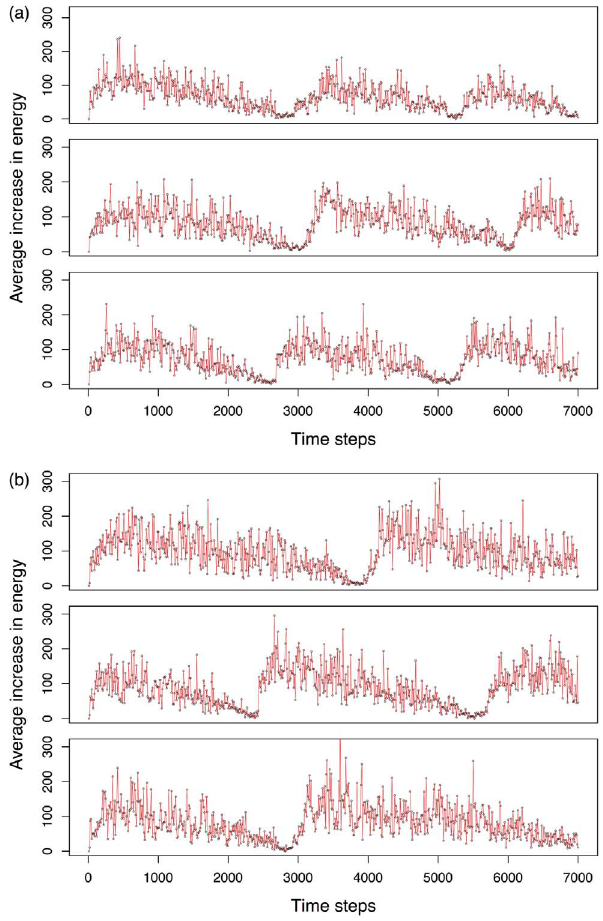
Figure 6. Comparison of the GRN controller robots with and without feedback. The Y-axis represents the average (of the entire robot population) increase in energy measured over ten time steps, while the X-axis represent running time measured in time steps. a) Three consecutive simulations are shown for robots with GRN controllers with all feedback disabled. b) Three consecutive simulations are shown for robots with GRN controllers with feedback enabled. Drops in average energy increase are caused by food resource exhaustion. When the number of robots in the population drops below 100, food resources are initialised again (see Text S5), causing the population to recover. See text for details.